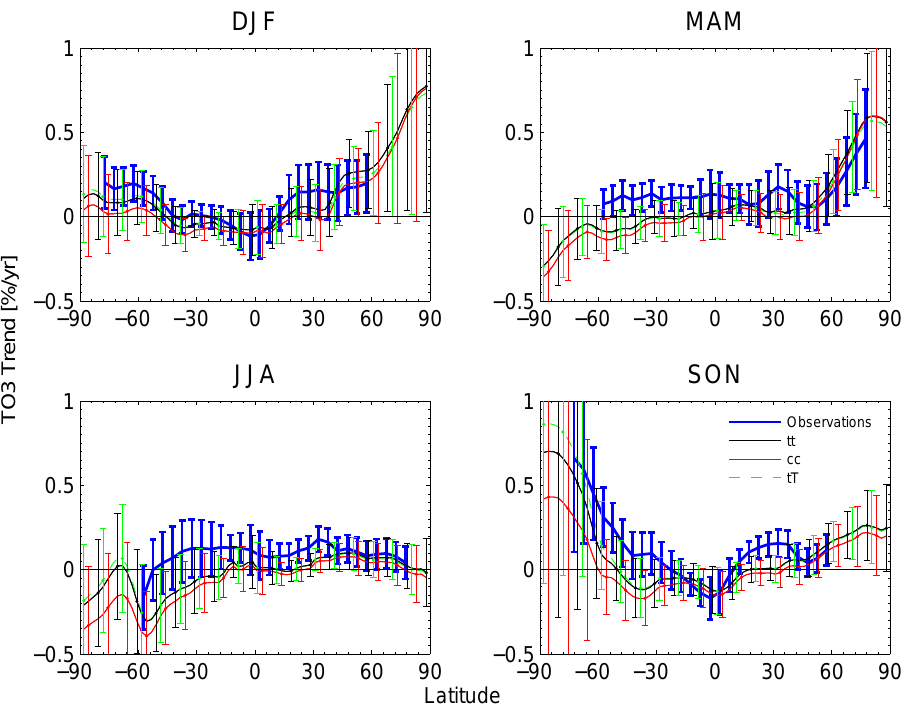
Fig. 8. Like Fig. 7, but for the 2000–2009 period. Modelled TO3 trends are compared to the combined TOMS/SBUV+ GOME/SCIAMACHY/GOME2 TO3 trends (“Observations”), obtained from the time series with solar and aerosol signals removed. To- tal trends ( ˆ ω 12 = ˆ ω 1 + ˆ ω 2 ) from model runs with EESC-dependent chemistry and polar chemistry ( tt , black line, and tT , green dashed line) and constant conditions ( cc , red line) are shown. Trends are given in percent of 1980 values per year. Error bars represent the 1 σ variance as obtained from the residuals of the linear